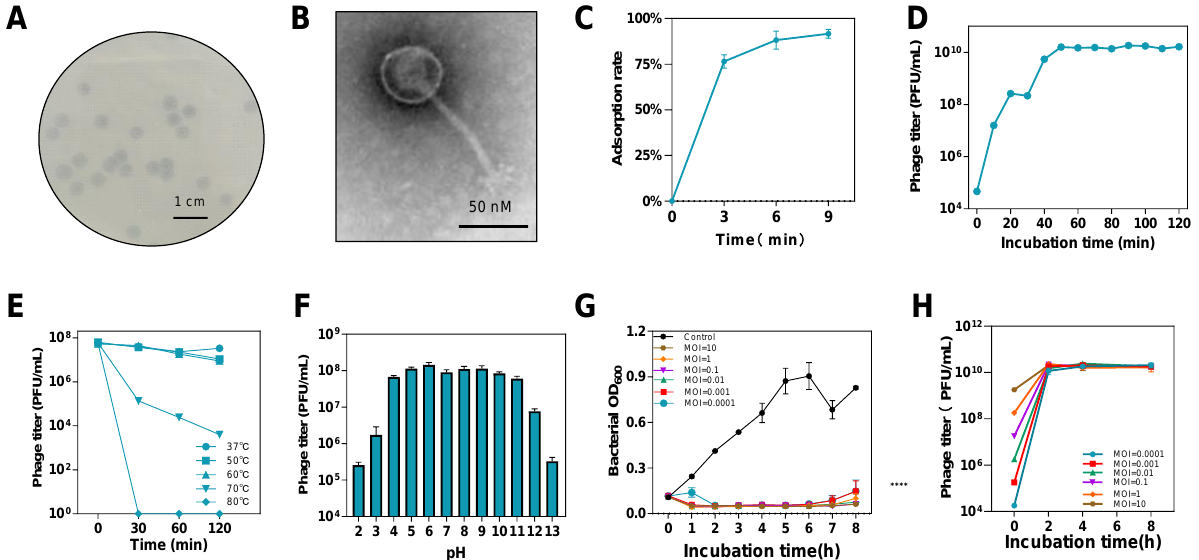
Figure 2. Characteristics of phage CKT1 and bacteriostatic ability in vitro. ( A ) Plaque morphology of phage CKT1 against S. Pullorum CVCC526. ( B ) Morphology of phage CKT1. ( C ) Adsorption rate of phage CKT1. ( D ) One-step growth curve of phage CKT1. ( E ) Temperature sensitivity of phage CKT1. ( F ) pH sensitivity of phage CKT1. ( G ) The bacteriostatic ability of phage CKT1 at different MOIs. ( H ) Phage CKT1 titer at different MOIs. Means of results from three independent assays are shown, and error bars represent the standard deviations.